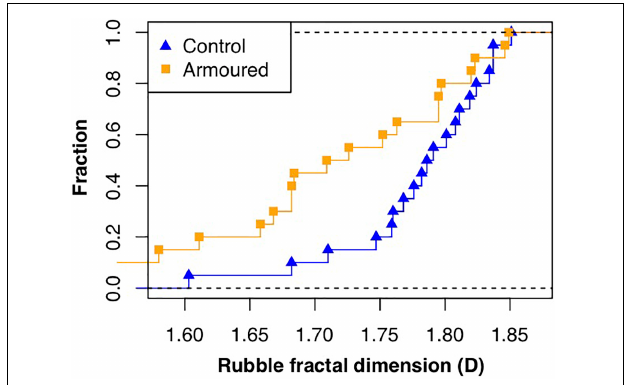
FIGURE 4 | Cumulative curves of rubble fractal dimension (D) at breakwater and control